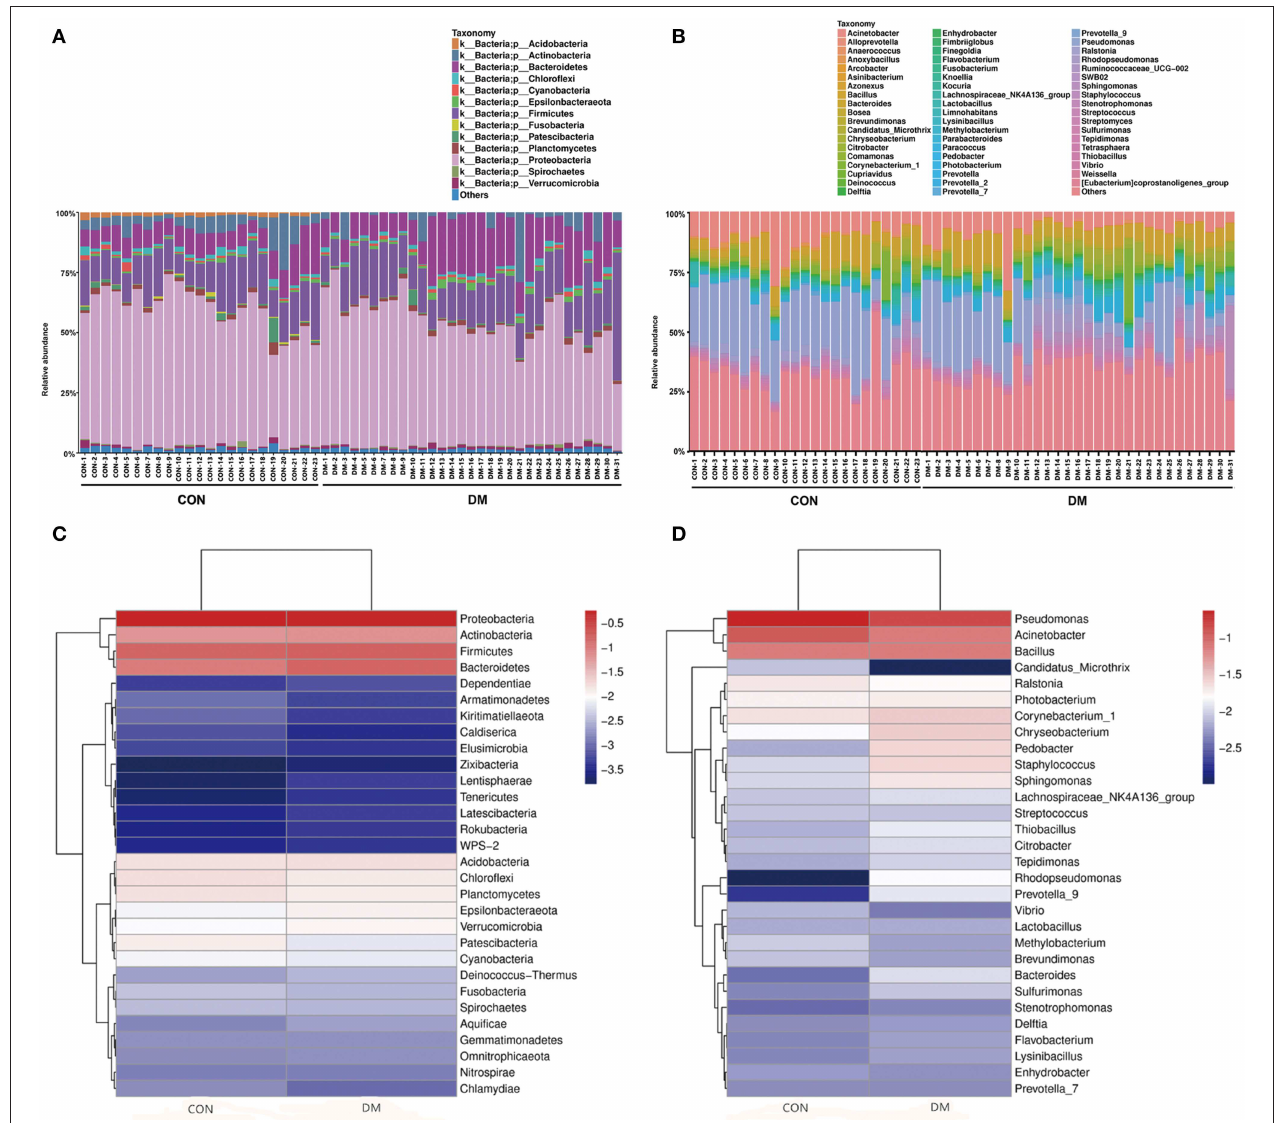
FIGURE 1 | Differences in the relative abundances of phylotypes in ocular microbiota between DM patients and healthy subjects. Each phylotype (1% of average relative abundance in the groups) is indicated by a different color at the genus level. (A) Bacterial taxon plots at the phylum level. (B) Bacterial taxon plots at the genus level. (C) Heat map of the top 30 phyla between two groups. (D) Heat map of the top 30 genera between two